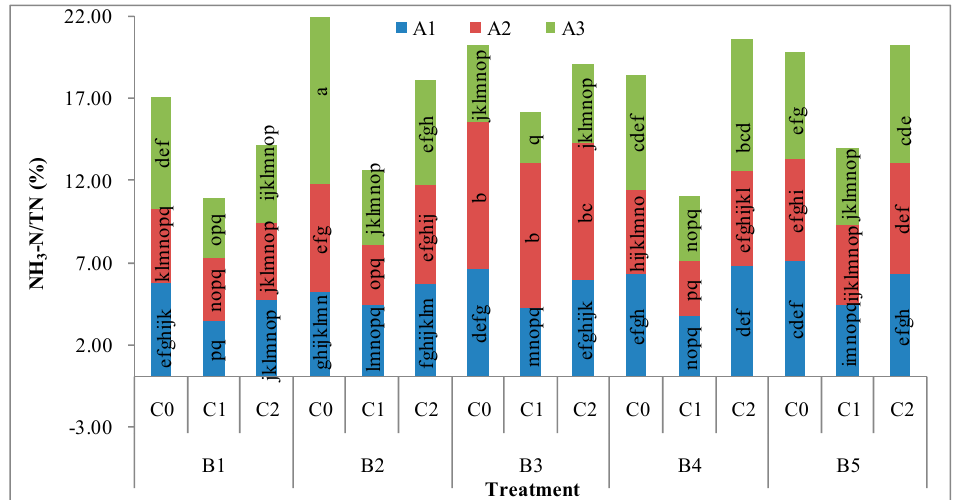
Figure 8. Differences in NH 3 -N/TN contents depending on the interaction between forage species, cutting stage and additive. NH 3 -N/TN: the ratio of ammonia nitrogen to the total nitrogen. A1: triticale; A2: rye; A3: oat; B1: heading stage; B2: flowering stage; B3: grouting stage; B4: milky stage; B5: dough stage; C0: additive-free treatment; C1: Sila-Max; C2: Sila-Mix. a b c d e et al. indicated the significant difference level between treatments ( p < 0.05). If all marked letters between the two treatments had a same letter, the difference between the two treatments was not significant, and if the marked letters were all different between the two treatments, the difference was significant.